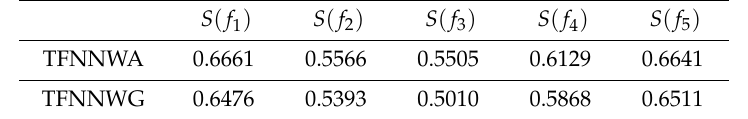
Table 13. The results of ranking order of alternatives. Table 11. The score function value of alternatives S ( f i ) .